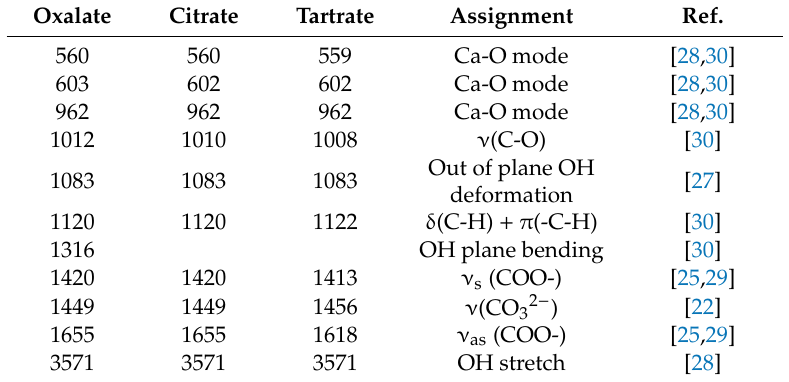
Figure 7. Comparison of the subtracted FTIR spectra of tartrate, citrate and oxalate ions adsorbed on hydroxyapatite.